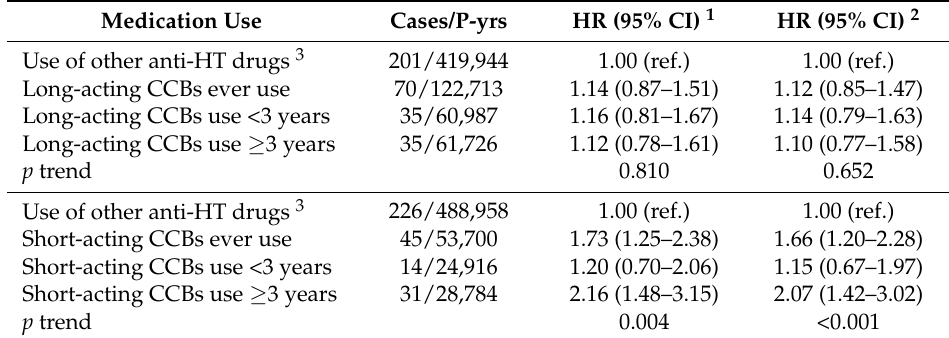
Table 3. Use and duration of use of long-acting and short-acting CCBs in association with risk of incident pancreatic cancer.